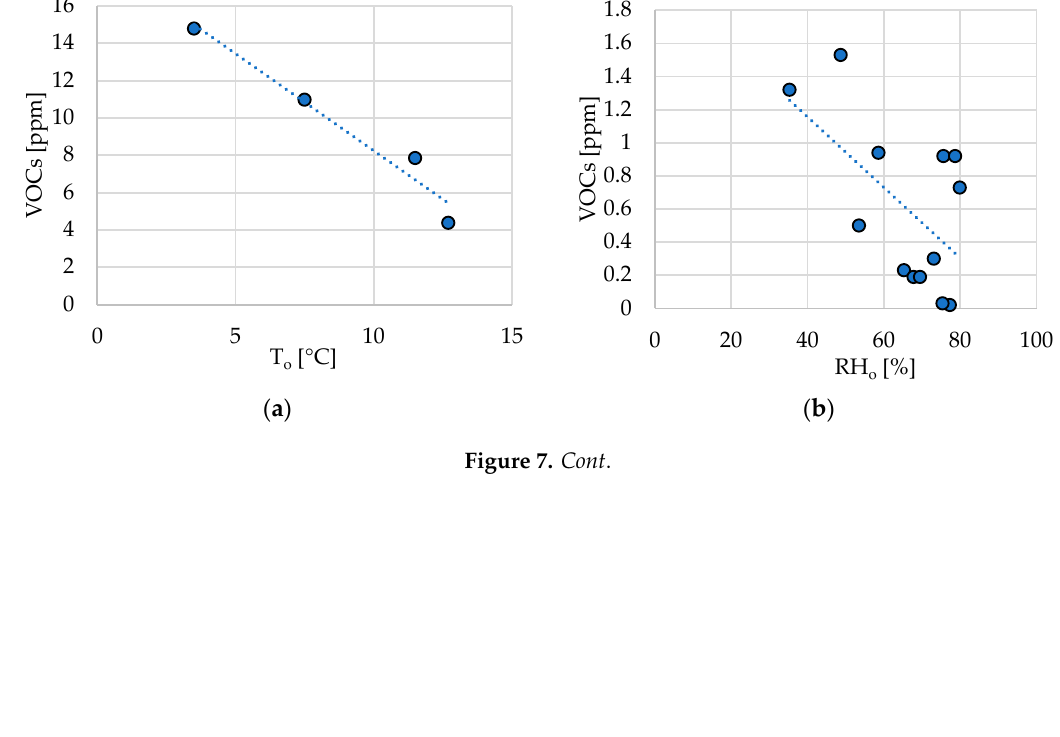
Figure 6. Correlation diagrams between VOC concentration in the mechanical treatment section of A biogas plant and measured RH i parameter with regression line: R 2 =